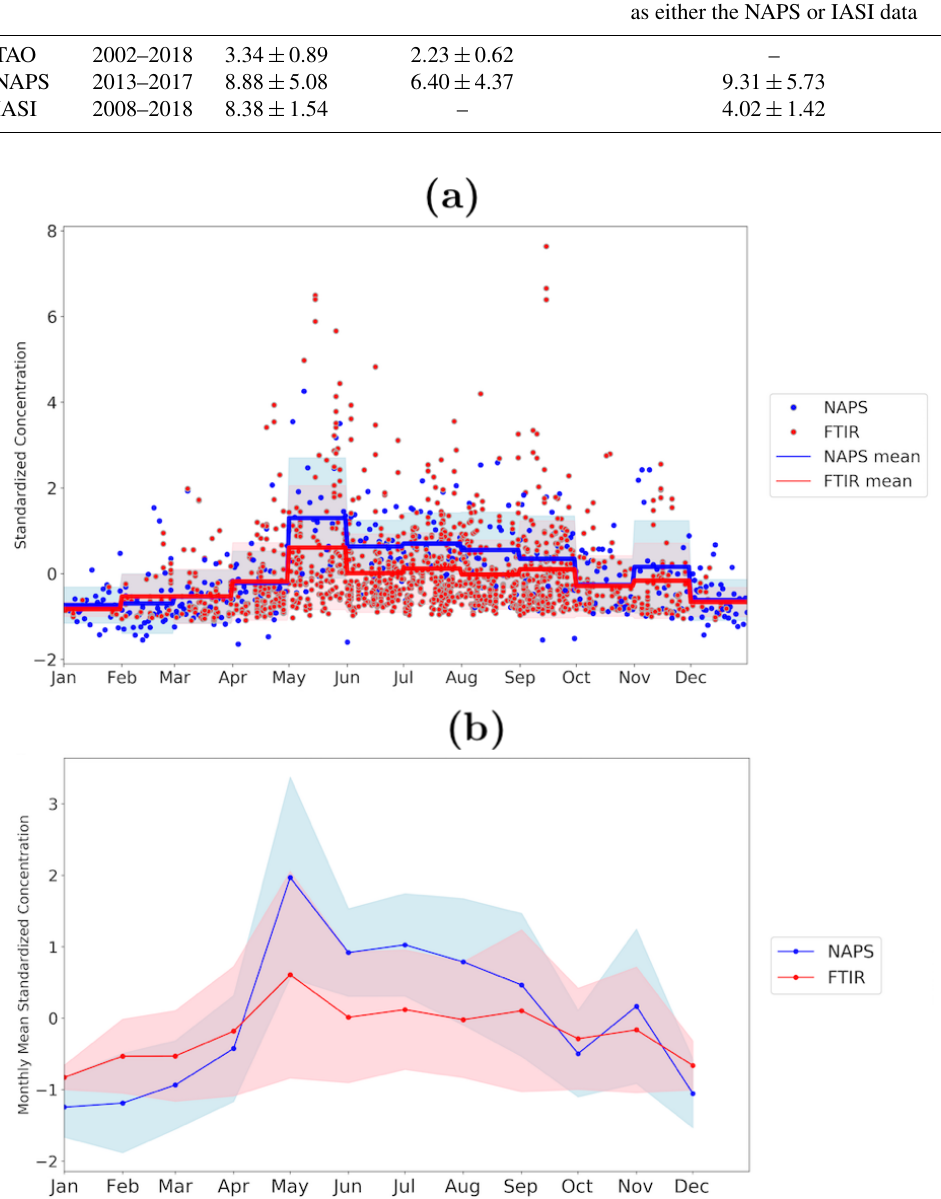
Figure 4. (a) Standardized FTIR total column and NAPS surface VMR of NH 3 plotted from January to December. Monthly averages and ± 1 σ are indicated by the red and blue lines and shading for the FTIR and NAPS, respectively. (b) The standardized FTIR NH (red) and NAPS surface NH 3 VMR (blue) monthly average lines with their respective ± 1 σ (shading).